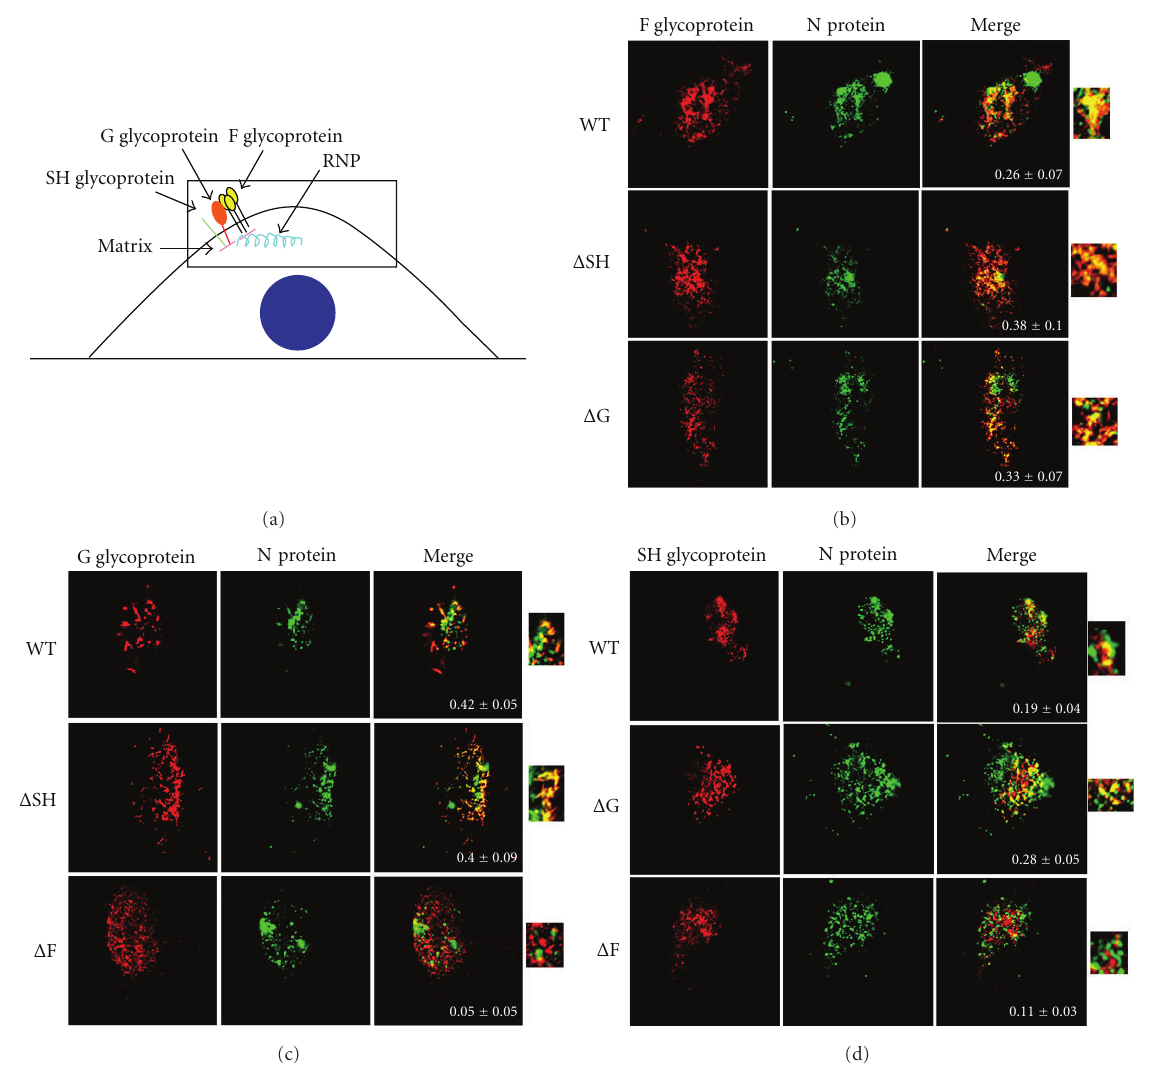
Figure 2: E ff ect of the deletion of individual glycoprotein genes on colocalization of the HRSV nucleocapsid protein with each glycoprotein at the plasma membrane. (a) A diagram of an infected cell depicting HRSV assembly at the plasma membrane. The boxed area represents the 1 µ m z -stack shown in subsequent confocal microscope images. The nucleus is depicted as a blue circle. A549 cells infected with WT or glycoprotein deleted HRSV at a MOI of 0.2 were fixed, permeabilized, and incubated with an anti-N antibody and an anti-F antibody (b), an anti-G antibody (c), or an anti-SH antibody (d). The glycoprotein stains are shown in the left row (red), the N protein stains in the middle row (green), and a merge of the two stains in the right row. A blowup of the merge is also shown. Images were taken on a Zeiss confocal microscope. An average of fourteen cells were imaged per staining, and colocalization was measured using ImageJ JACoP plugin. Pearson’s coe ffi cient ± standard error of mean is shown within the merge